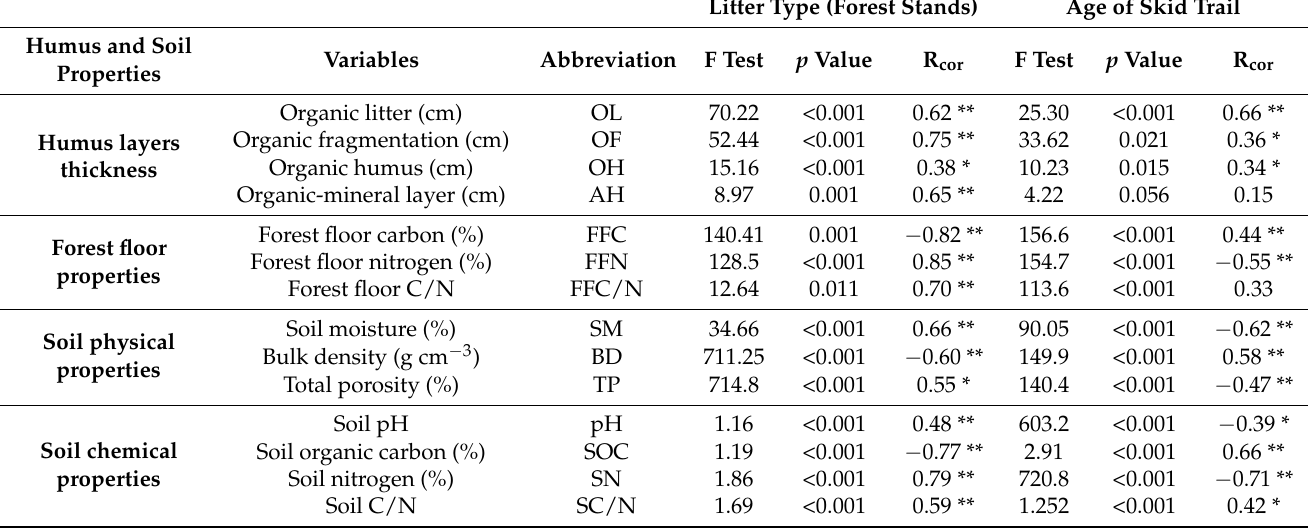
Table 2. One-way analysis of variance (ANOVA) and Pearson’s correlation coefficients (R cor ) of forest floor and soil properties under the influence of litter type treatments (forest stands) and skid trail age. (*): p < 0.05; (**): p <